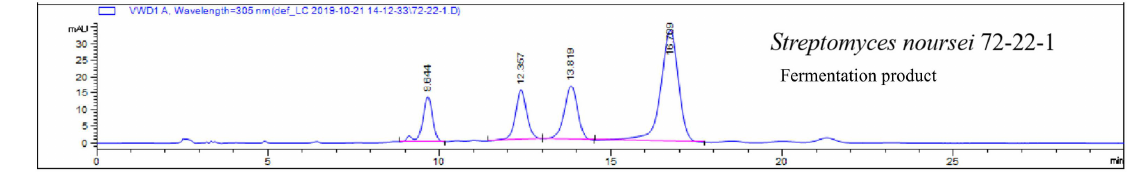
Figure 5. Evaluation results for single factors of glucose concentration, peanut meal concentration, starting pH, and inoculation volume ratio for fermentation.